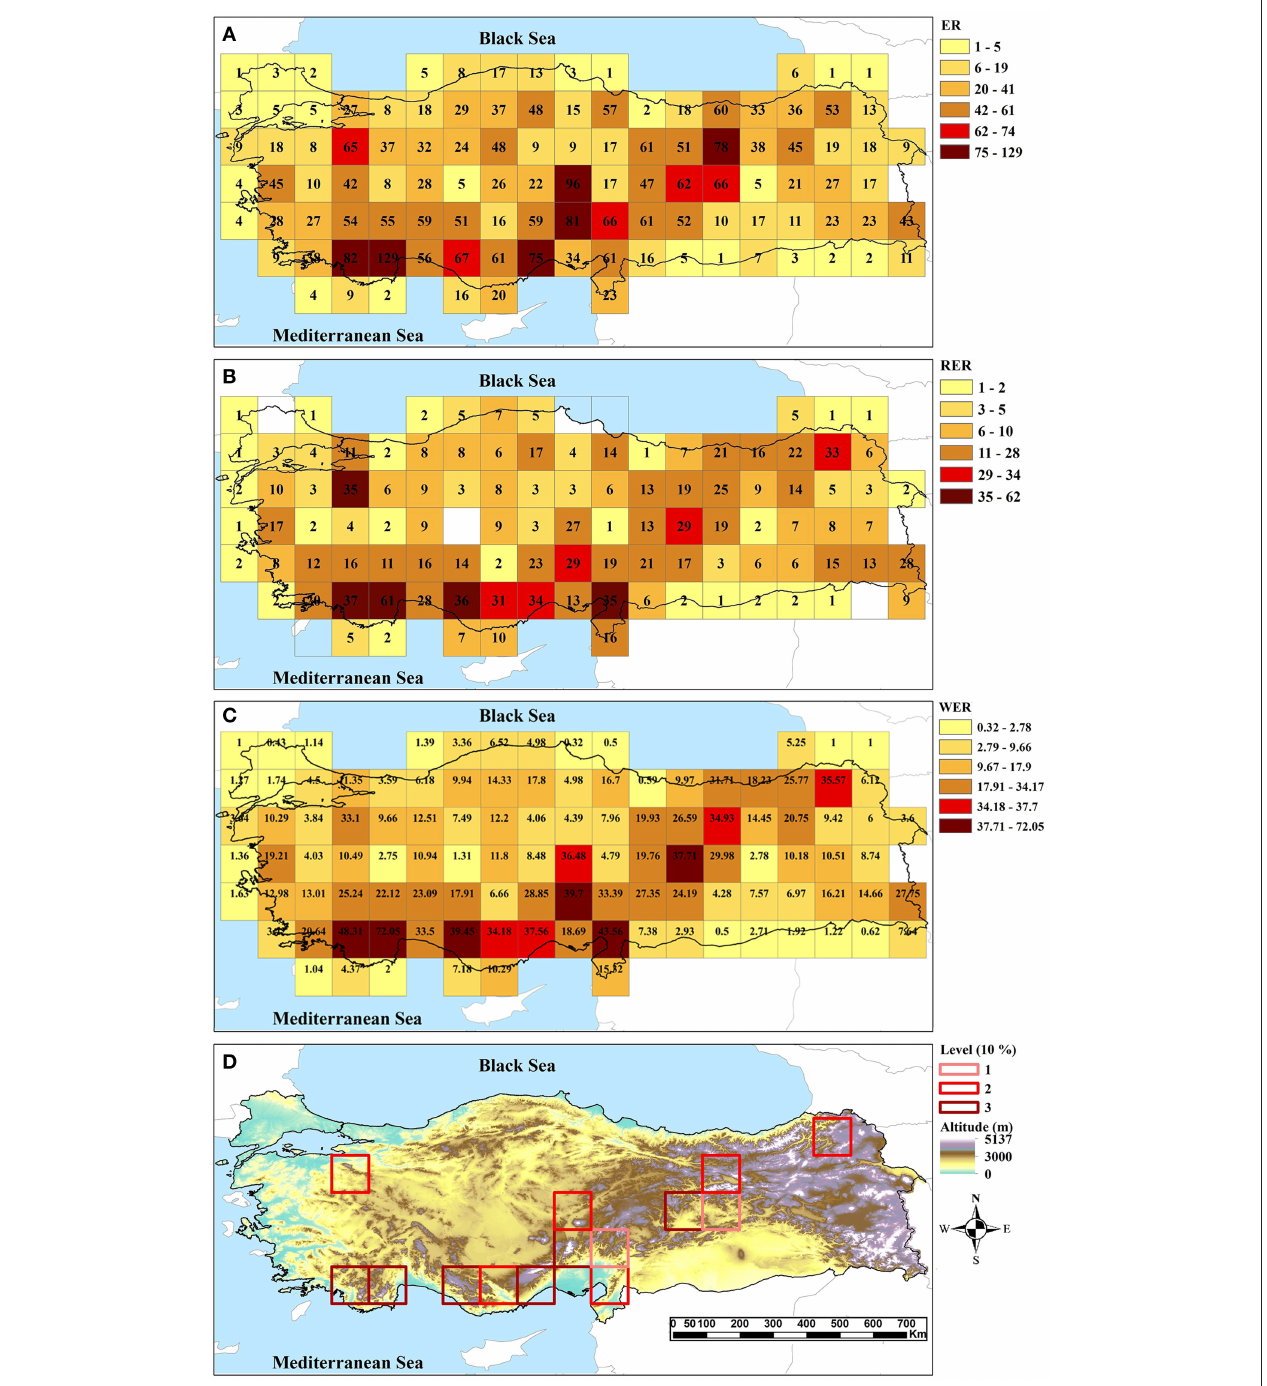
FIGURE 2 | Centers of endemism in the study area identified by (A) endemic richness, (B) range-restricted endemic richness, (C) weighted endemic richness, and (D) their intersection (1: supported by one index, 2: supported by two indices, 3: supported by three indices). In (A–C) the two highest categories correspond to the 5 and 10% richest